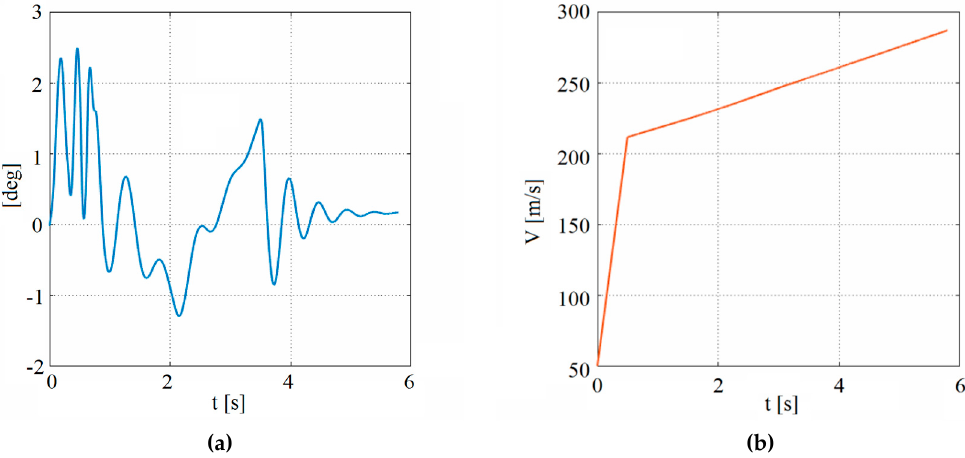
Figure 10. The performed control forces ( a ) and moments ( b ) of the anti-tank guided missile flight in the horizontal plane.